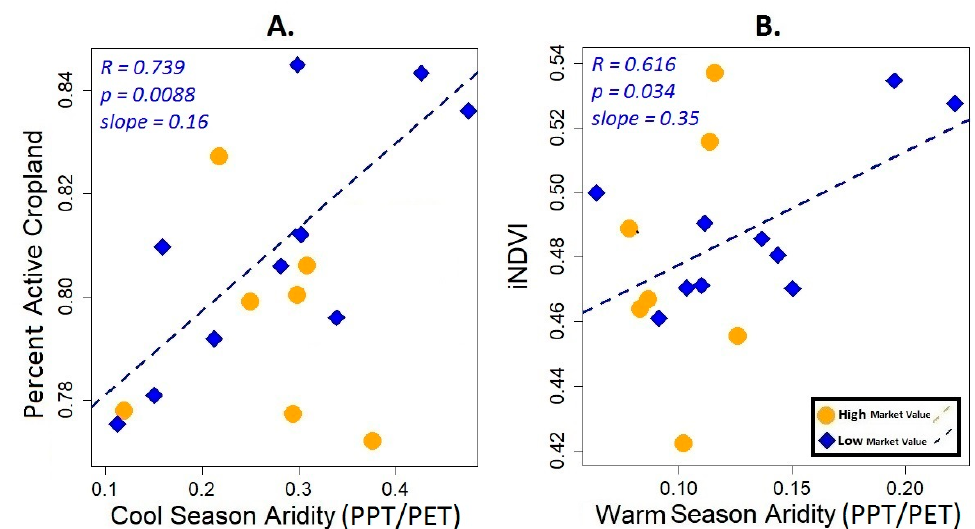
Figure 5. The role of crop market value in the coupling of active cropland extent and active cropland productivity (iNDVI) to climate. PPAMA active cropland extent ( A ) and iNDVI ( B ) were most sensitive to mean cool season aridity during years of low market value (blue diamonds). Dashed lines show the linear regression fit of the low-market value relationships, which are significant ( p < 0.05); Correlations and slopes are reported in the plot.